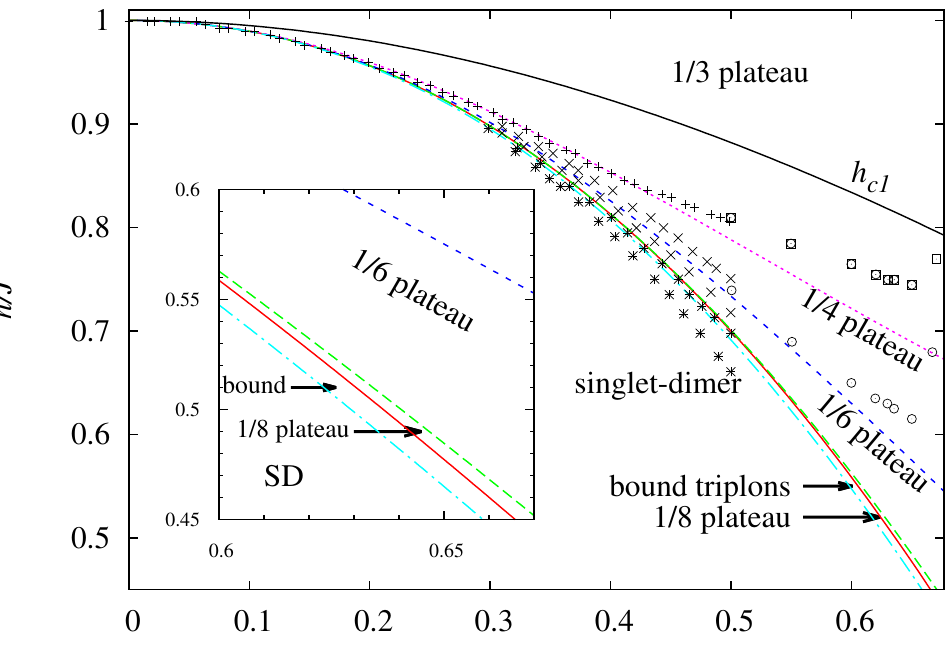
Figure 9: The ground-state phase diagram of the spin-1 / 2 Heisenberg model on the Shastry-Sutherland lattice in the J (cid:48) / J − h / J plane. The critical fields (8) de- rived within the perturbation theory, which was developed from the exactly solved Ising-Heisenberg model up to the second order, are shown by lines of different styles: h (red solid curve), h (green dash curve), h (blue short- 0 − 1 / 8 1 / 8 − 1 / 6 1 / 6 − 1 / 4 dash curve), h (magenta dotted curve). The lowest dash-dotted line corre- 1 / 4 − 1 / 3 sponds to the critical field h (12) discussed in Sec. 4. Symbols “ + ” display bound − t the phase boundary between the 1 / 4- and 1 / 3-plateaux, while the field range delim- ited by symbols “ × ” corresponds to the 1 / 6-plateau (for N = 36 spins) and the field range delimited by symbols “ ∗ ” corresponds to the 1 / 8-plateau (for N = 32 spins) obtained by the numerical CORE method [ 5 ] . Empty squares and circles show iPEPS results for lower critical fields of the 1 / 3- and 1 / 4-plateaux, respectively [ 10 ] . The inset shows an enlarged scale of the phase diagram for the J (cid:48) / J interval close to the presumable microscopic parameters for SrCu (BO ) 2 3 2